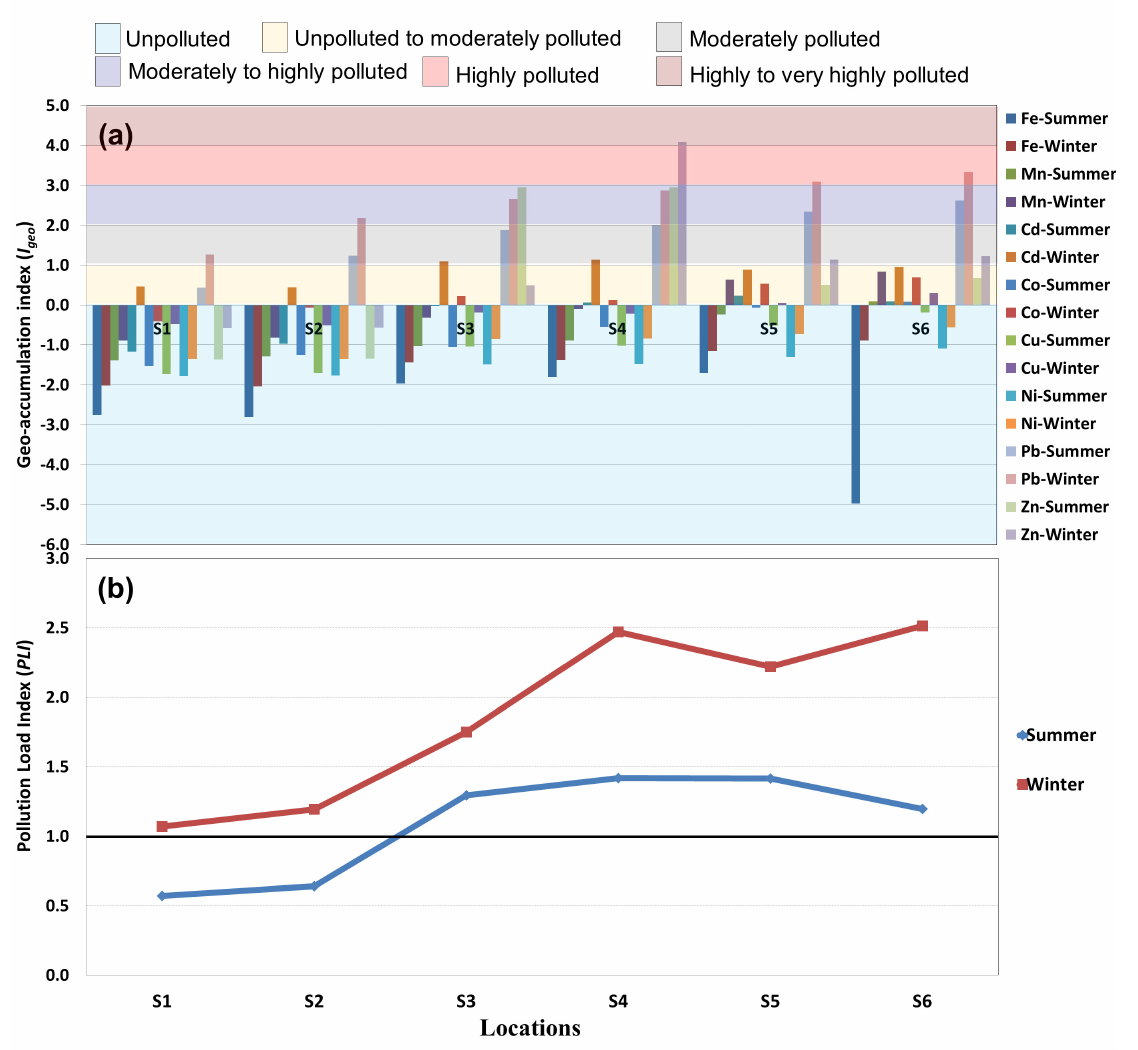
Figure 3. The Geo-accumulation index (Igeo) ( a ) and the pollution load index (PLI) ( b ) of toxic trace metals in Damietta branch sediments during summer and winter